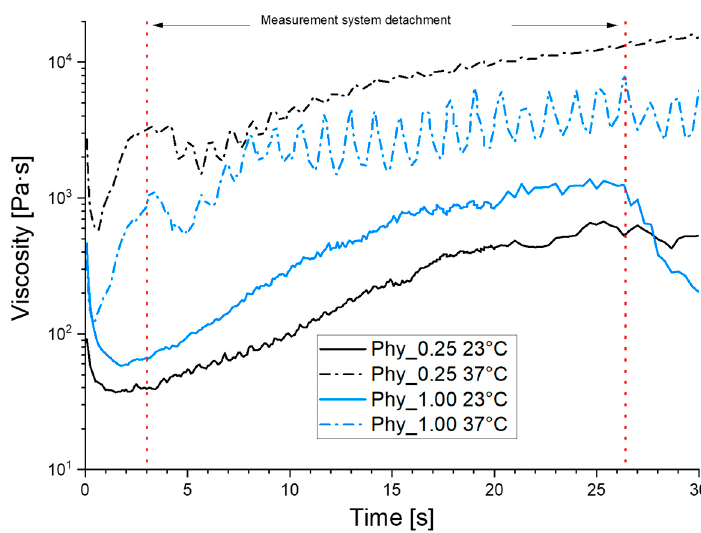
Figure 3. The paste viscosity development of the samples Phy_0.25 (black) and Phy_1.00 (blue) at 23 ◦ C (line) and 37 ◦ C (dotted line). The reference Phy_0.00 was not measurable. Every sample was prepared three times independently, and one representative curve is shown.